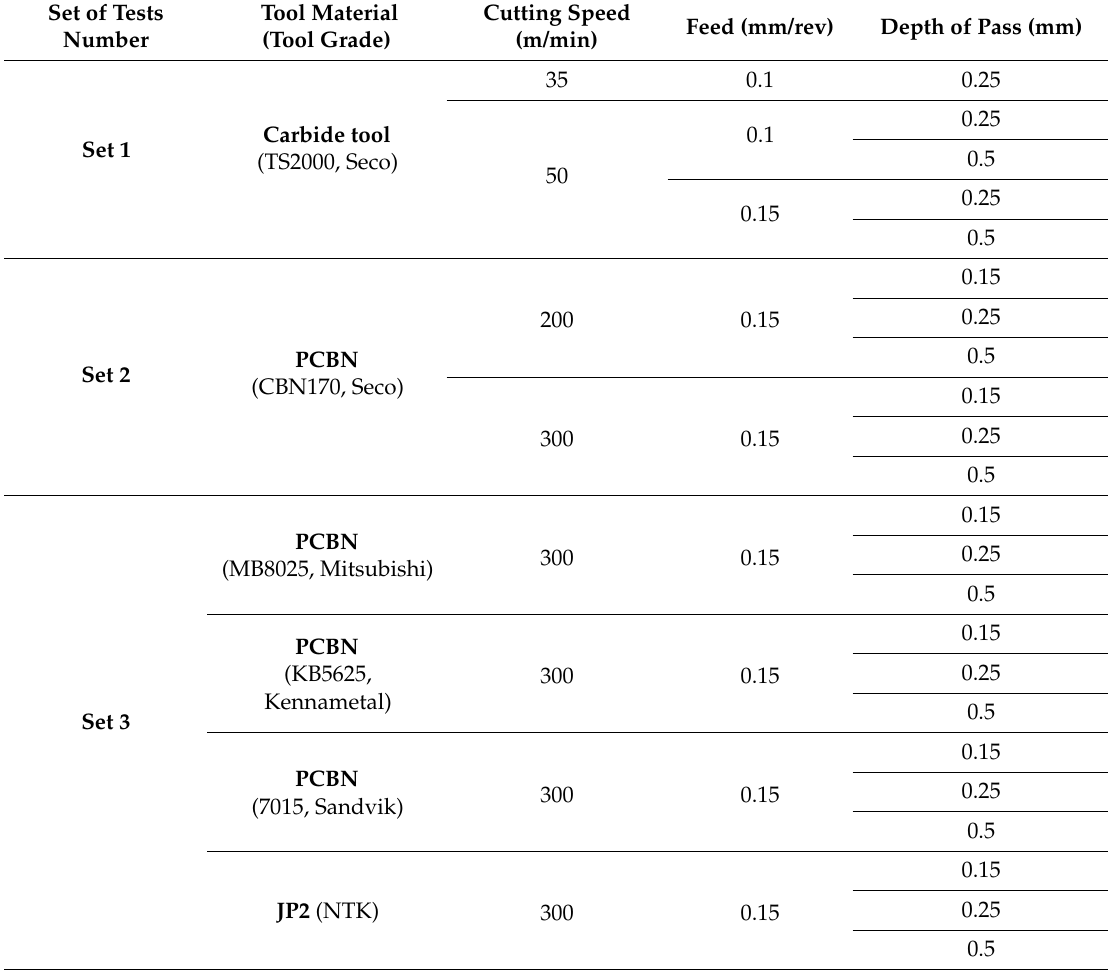
Table 3. Cutting conditions for tool wear tests: Seco coated carbide tool (Set 1); Seco PCBN tool (Set 2) and other manufacturers PCBN tools and JP2 grade (Set